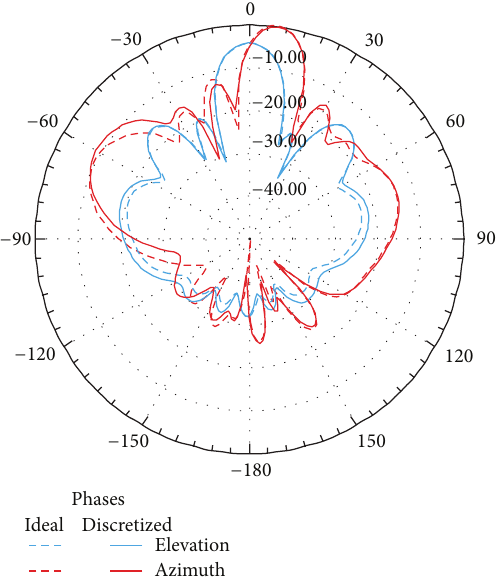
Figure 11: Pattern steered by 7.5 ∘ generated by a virtual array of 5 contiguous subarrays on the full cylindrical array. Dashed lines are obtained with ideal phase shifts and solid lines with discretized phase shifts.